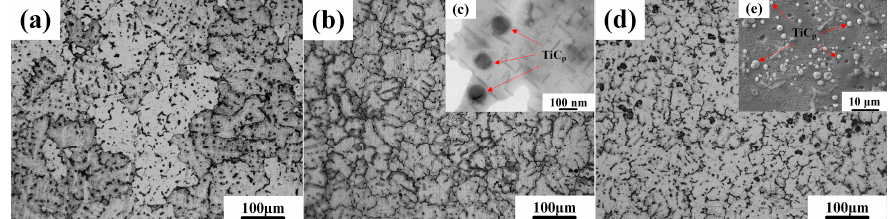
Figure 2. The typical optical microstructures of the as-cast ( a ) Al-Cu matrix alloy, ( b ) 0.5 wt.% nano-sized TiC p /Al-Cu composite and ( d ) 5.0 wt.% micro-sized TiC p /Al-Cu composite; ( c ) the TEM micrograph of the 0.5 wt.% nano-sized TiC p /Al-Cu composite; ( e ) the SEM micrograph of the 5.0 wt.% micro-sized TiC p /Al-Cu composite.